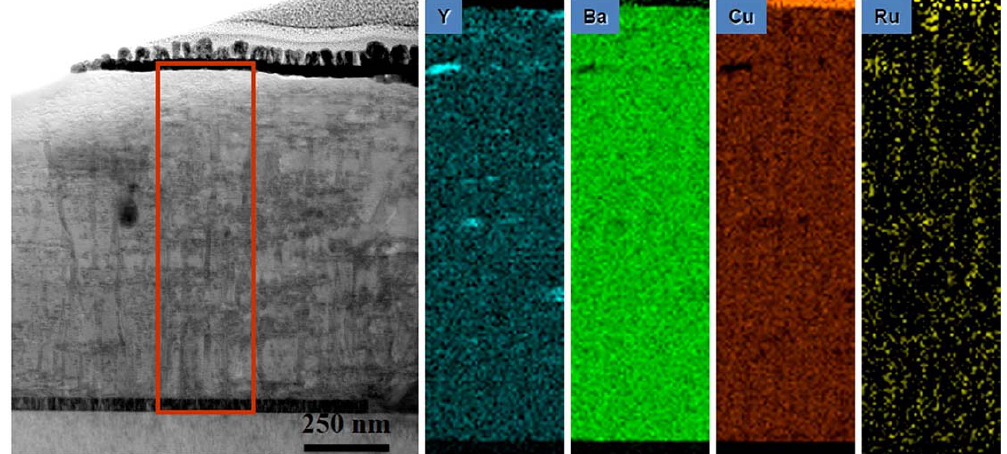
Figure 6. STEM bright-field image and associated energy dispersive spectral imaging showing Ru in secondary